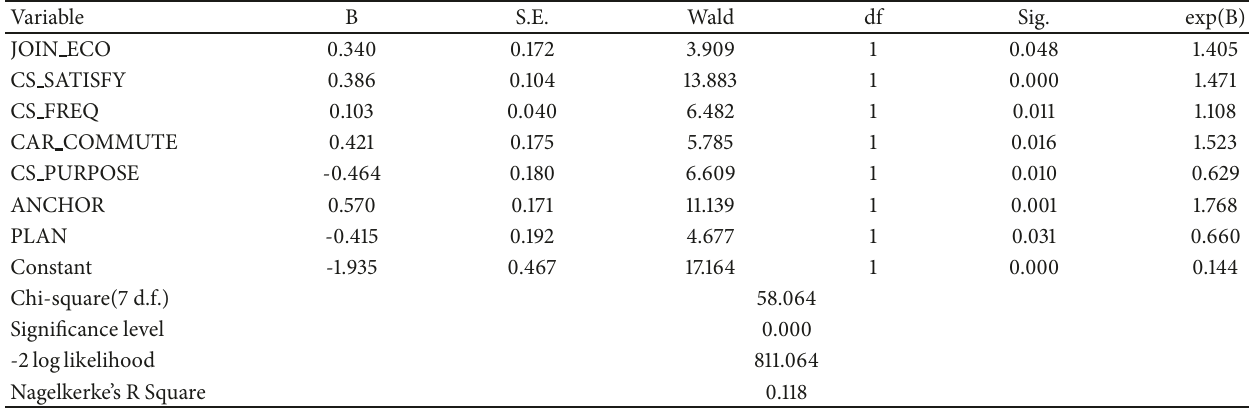
Table 12: The result of binominal logit